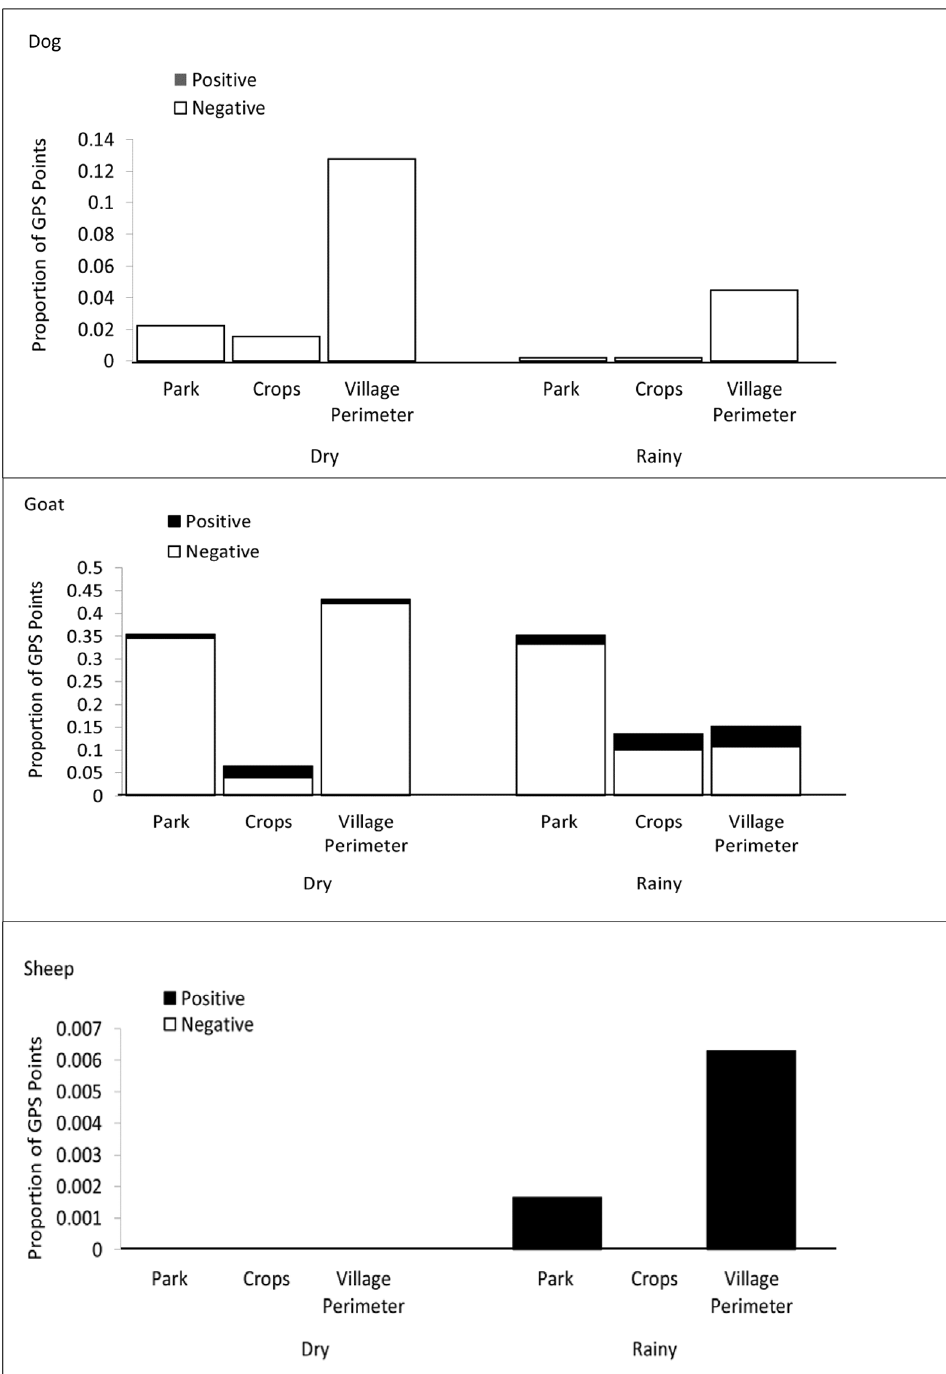
Figure 3. The proportion of GPS points from infected and uninfected domesticated animals in the defined study area in Mwamgongo village and Gombe National Park, Tanzania, during the dry and wet seasons. Infected animals (Goat: n=5, Sheep: n=2, Dogs: n=0).